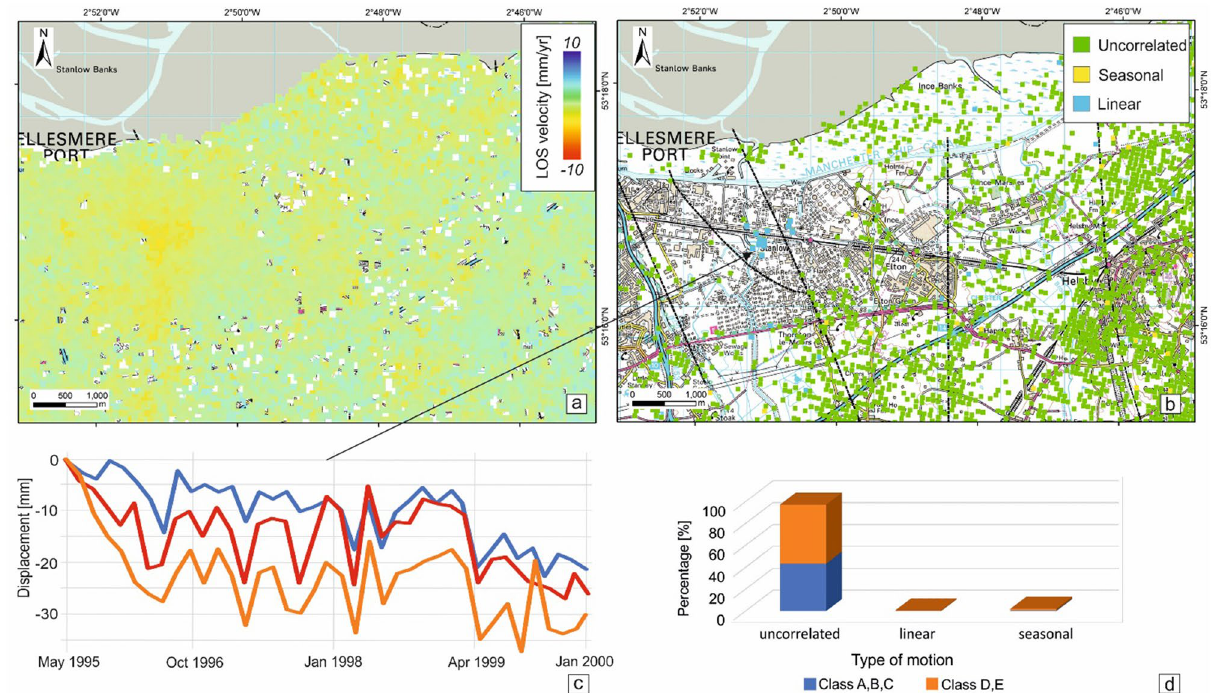
Figure 3. Ground stability condition for the Cheshire Observatory during 1995–2000. ( a ) ISBAS results from ERS data, ( b ) classification of the unstable InSAR time series, ( c ) time series for four ISBAS points within the study area and ( d ) percentage of type of motion according to the GeoSure susceptibility classes in the compressible ground and running sand susceptibility layers. Contains Ordnance Survey data, Crown copyright and database right 2018, license number 100021290 EUL. Contains British Geological Survey materials, UKRI 2021. Contains Terra Motion Limited 2017